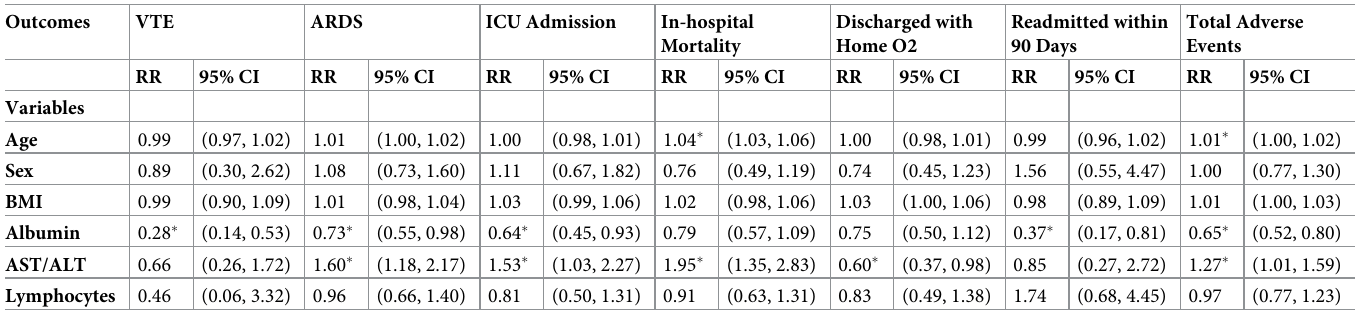
Table 3. Multivariate